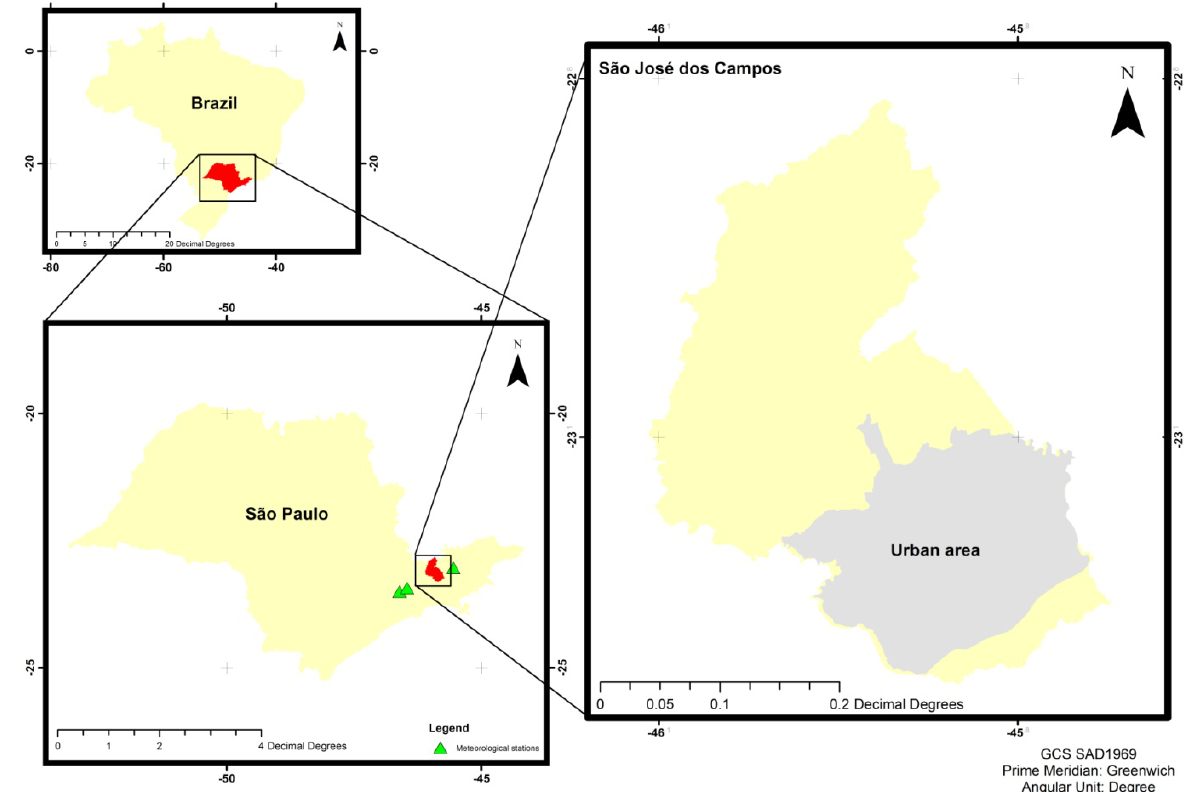
Figure 1. Location of São Paulo State (red) in Brazil; Location of São José dos Campos (red) in São Paulo State and the INMET meteorological stations (red points) near the study area; and the urban area of São José dos Campos (red) within the total area of the